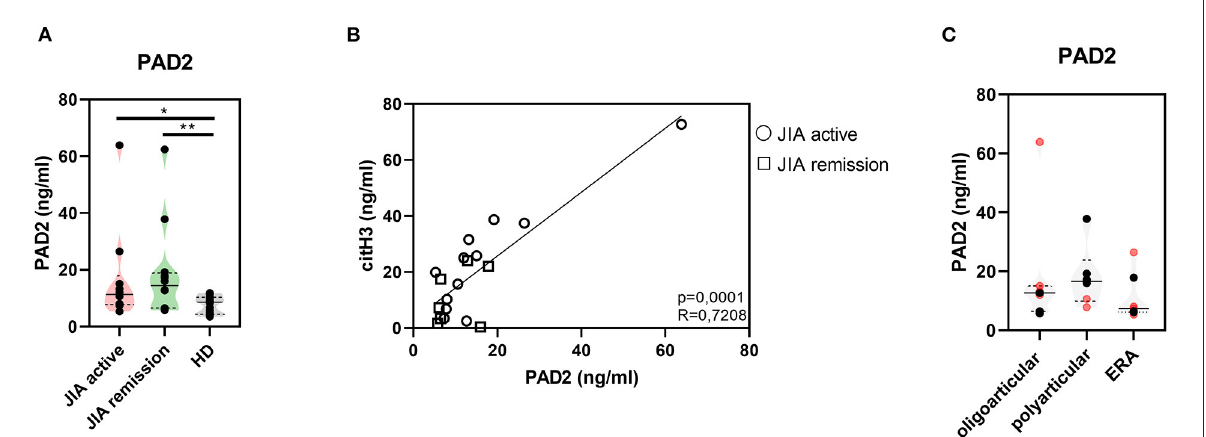
FIGURE2 Peptidyl arginine deiminase 2. (A) Peptidyl arginine deiminase 2 (PAD2) concentrations in JIA active ( n = 10), JIA remission ( n = 10), and healthy donors (HD = 16) detected using ELISA. (B) Relationship between the PAD2 and citH3 levels in JIA active and JIA remission groups. (C) PAD2 levels in JIA subtypes: oligoarticular/oligo-extended, polyarticular, and ERA groups. Patients with active JIA are displayed in red and patients with JIA remission are shown in black. Values are standardized and expressed as median values. Statistical analyses were performed using unpaired